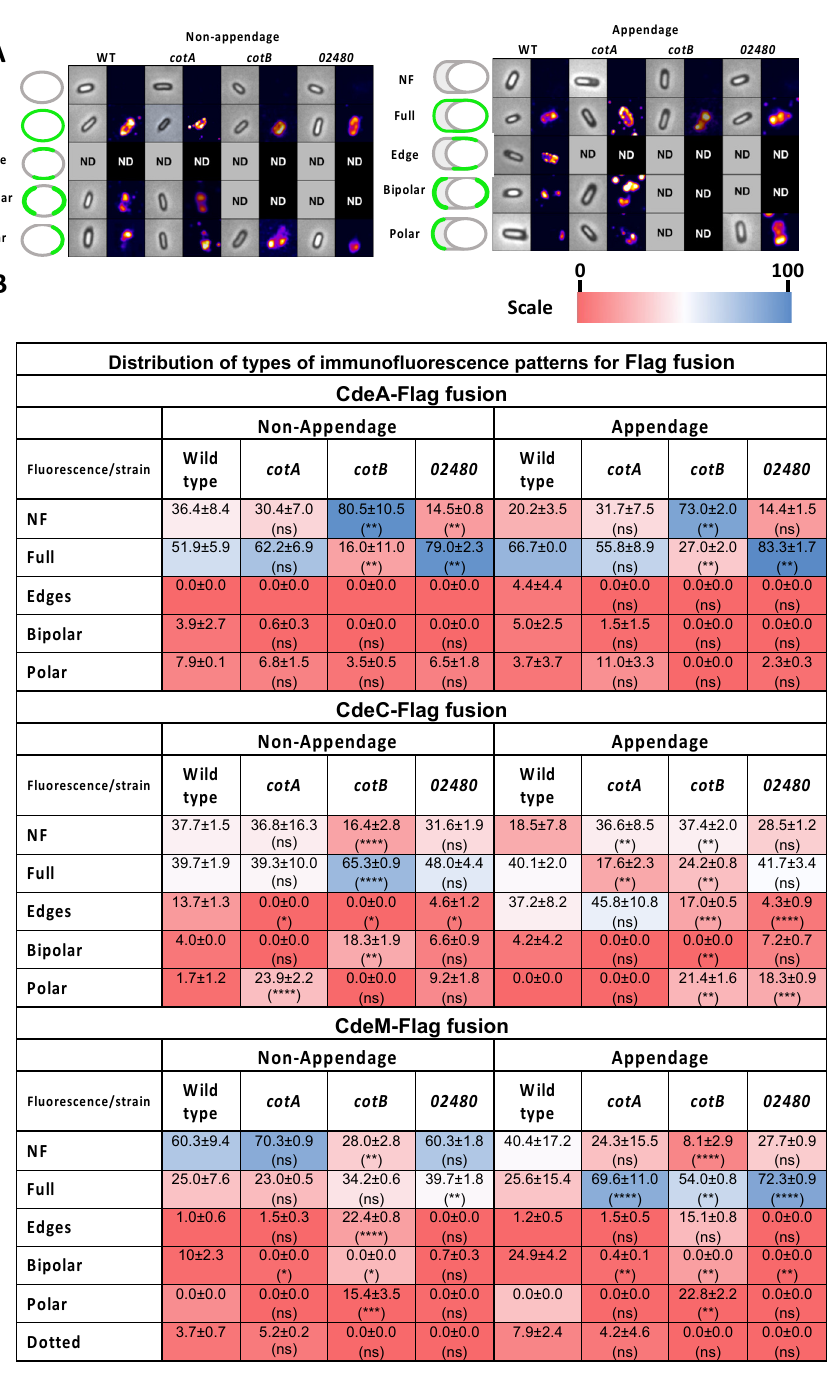
Figure 5. Effect of absence of spore coat proteins in accessible immunofluorescence of Flag fu- sions of cysteine-rich exosporium proteins . ( A ) Representative image of the distribution of fluo- rescent distribution pattern of CdeA-FLAG on the surface of non-appendage or appendage spores of wildtype and cotA (cotA::CT555a ), cotB ( cotB::CT329a ) and CDIF630_02480 ( CDIF630_02480::CT90a ) mutant strains. ( B ) Quantification of fluorescence patterns in non-append- age or appendage spores of wildtype cotA , cotB or CDIF630_02480 strains, which were first binned by presence or absence of appendage through phase contrast microscopy prior to fluorescence anal- ysis. Data represents the mean and error bars represent the standard error of the mean. Asterisks denote statistical dif- ference respect to wildtype (ANOVA and Bonferroni multiple comparison test), where * p < 0.05, ** p < 0.01, *** p < 0.001, **** p < 0.0001, and n.s., denotes no significant difference. Heat map depicts the percentage of total of the fluorescence distribution from 0 to